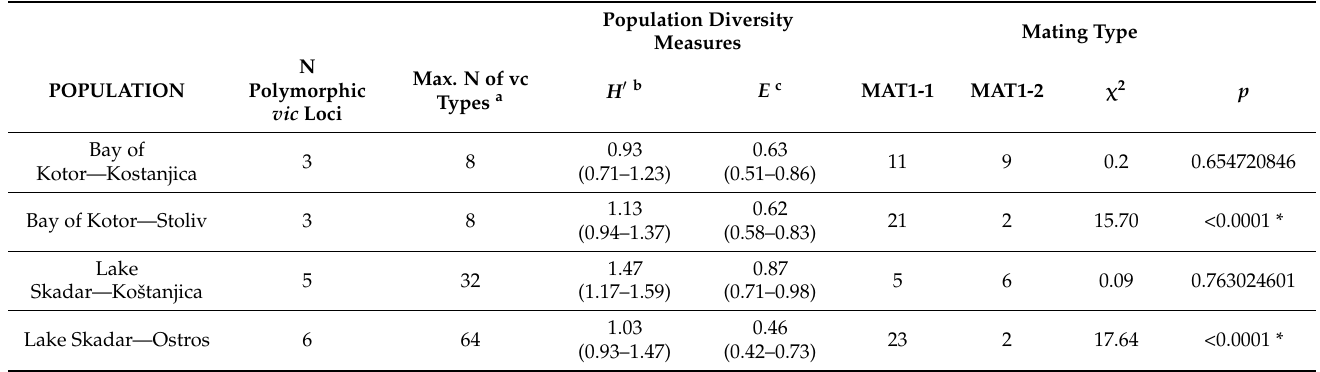
Table 3. Polymorphic vic loci, maximum number of vegetative compatibility types, population diversity measures, and mating types of Cryphonectria parasitica isolates from four populations in Montenegro. Statistically significant differences at p < 0.05 are denoted by an asterisk (*). Population Diversity Mating Measures